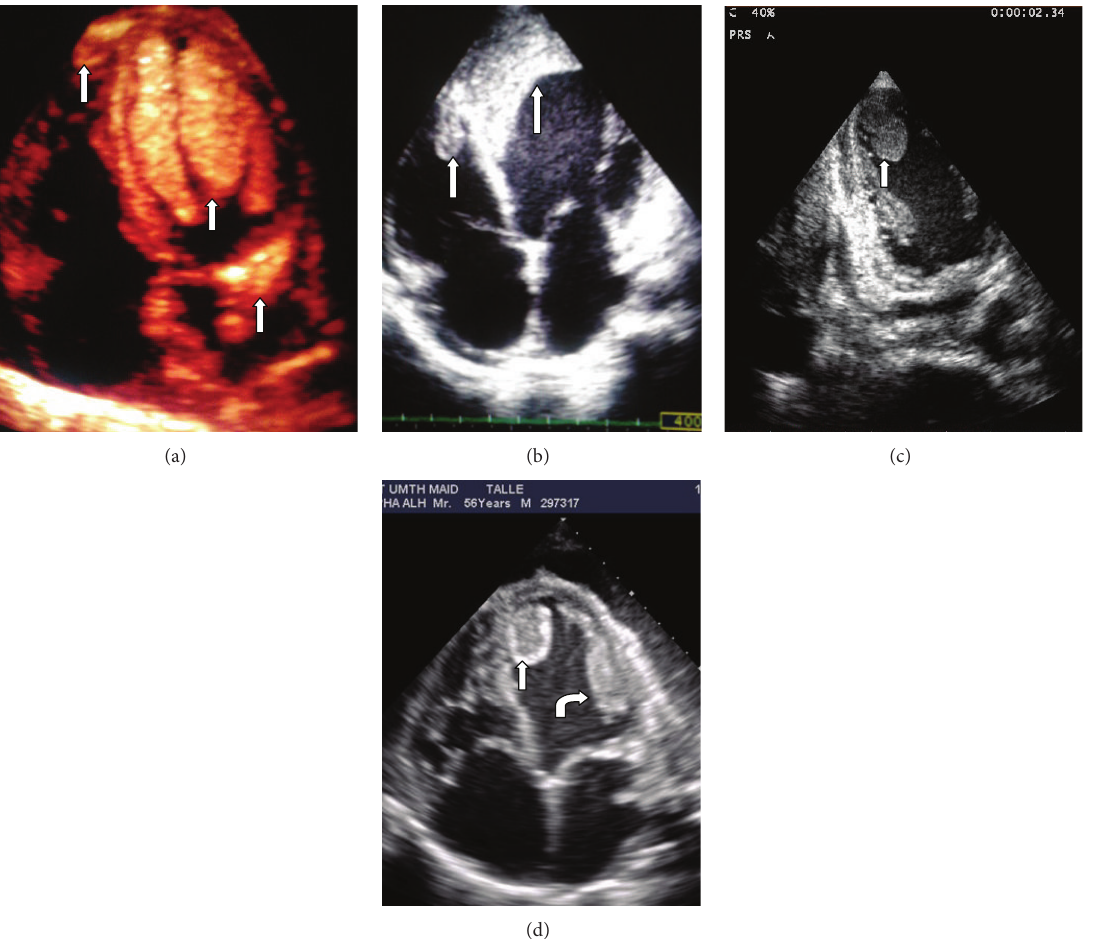
Figure 4: Images showing thrombus (white arrows) in various locations. (a) Biventricular and left atrial thrombi in a patient with PPCM. (b) Biventricular thrombi following anteroapical MI. (c) Off-axis plane showing apical LVT. (d) Multiple LVT with central lucency and LV spontaneous echo contrast in